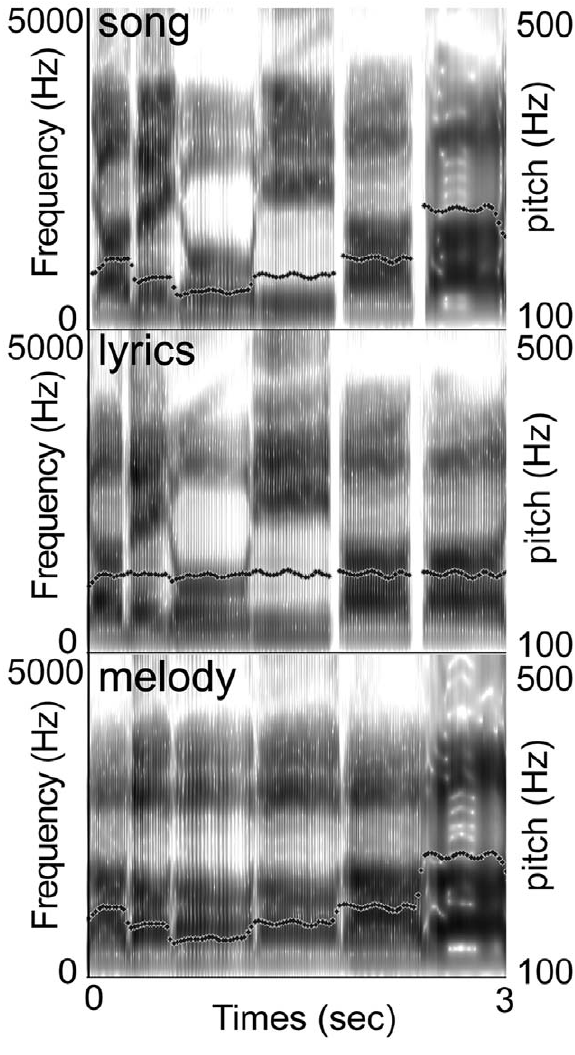
Figure 1. Acoustic analyses of three types of auditory stimuli: song, lyrics, and melody. Three images illustrate wide-band spectrograms of frequency information. Dotted lines represent pitch